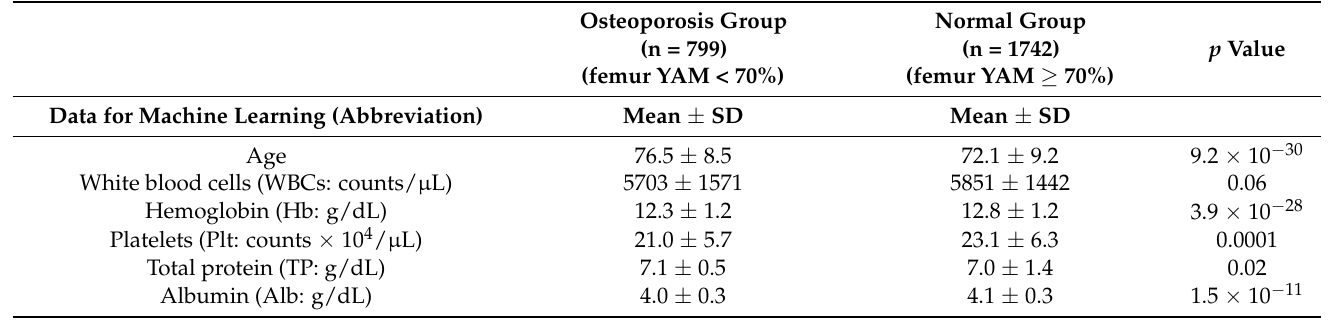
Table 2. Mean ± SD of each group, and p values of the unpaired t-test are shown in the right